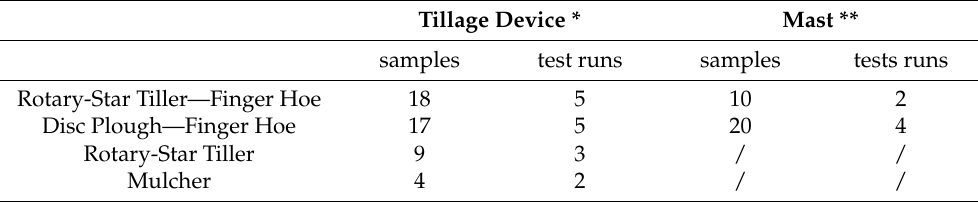
Table 1. Total number of samples and tests.